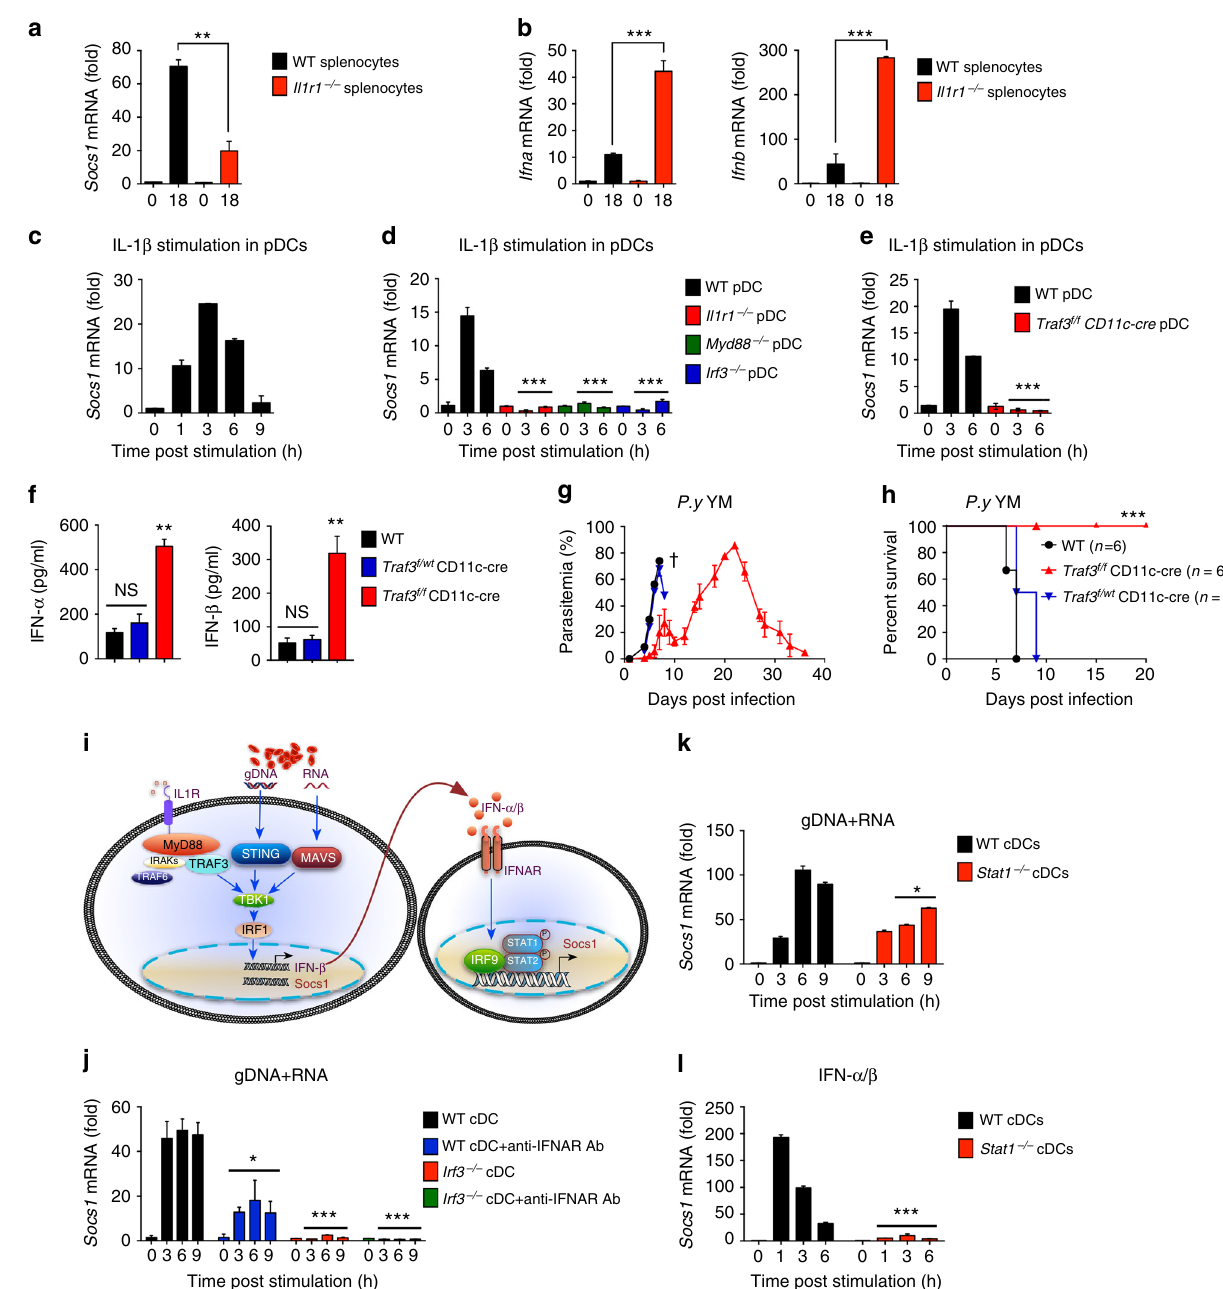
Fig. 6 Negative regulator SOCS1 is directly induced by IL-1 β signaling in a MyD88-TRAF3-IRF3-dependent type I IFN signaling. a , b WT and Il1r1 − / − mice ( n = 5) were infected with P. yoelii YM for indicated times, and RNA from splenocytes was isolated and used for expression analysis of Socs1 ( a ), Ifna and Ifnb ( b ) by using qPCR. c WT pDCs were stimulated with recombinant mouse IL-1 β (2 μ g/ml) for indicated times, RNA from the pDCs was isolated and used for expression analysis of Socs1 by using qPCR. d WT, Il1r1 − / − , Myd88 − / − , and Irf3 − / − pDCs were stimulated with recombinant IL-1 β (2 μ g/ml) for indicated times, RNA from pDCs was isolated and used for expression analysis of Socs1 by using qPCR. e WT and Traf3 f/f CD11c-cre pDCs were stimulated with recombinant IL-1 β (2 μ g/ml) for indicated times, RNA from pDCs was isolated and used for expression analysis of Socs1 by using qPCR. f – h WT, Traf3 f/f CD11c-cre , and Traf3 f/wt CD11c-cre mice ( n = 5) were infected with P. yoelii YM. Serum was collected at 24 h post infection and subjected to ELISA analysis for IFN- α , IFN- β ( f ). Parasitemias ( g ) and survivals ( h ) were monitored daily. i A model to show whether SOCS1 is directly induced by IRF3- dependent signaling or the downstream IFNAR-mediated signaling. j WT and Irf3 − / − cDCs were pretreated with or without anti-IFNAR antibody for 24 h and stimulated with YM gDNA plus RNA for indicated times. RNA from cDCs was isolated and used for expression analysis of Socs1 by using qPCR. k , l WT and Stat1 − / − cDCs were stimulated with YM gDNA plus RNA ( k ) or mouse IFN- α / β ( l ) for indicated times. RNA from splenocytes was isolated and used for expression analysis of Socs1 by using qPCR. Data are representative of three independent experiments and plotted as mean ± SD. * p < 0.05, ** p < 0.01, *** p < 0.001 vs. corresponding control. NS, not signi fi cant. Dagger denotes mouse